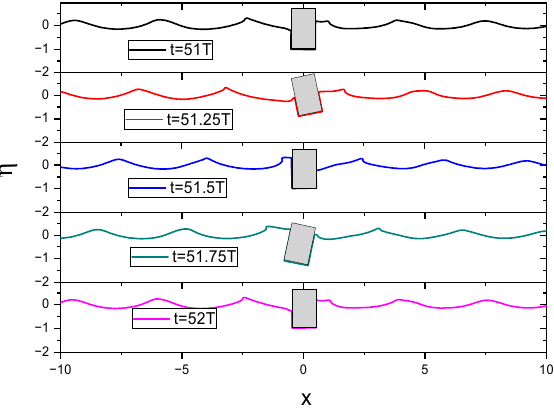
ω′ = ω (cid:48) = . Figure 17. Development of free surface profile for the body under combined motion when 0 ω ′ = .